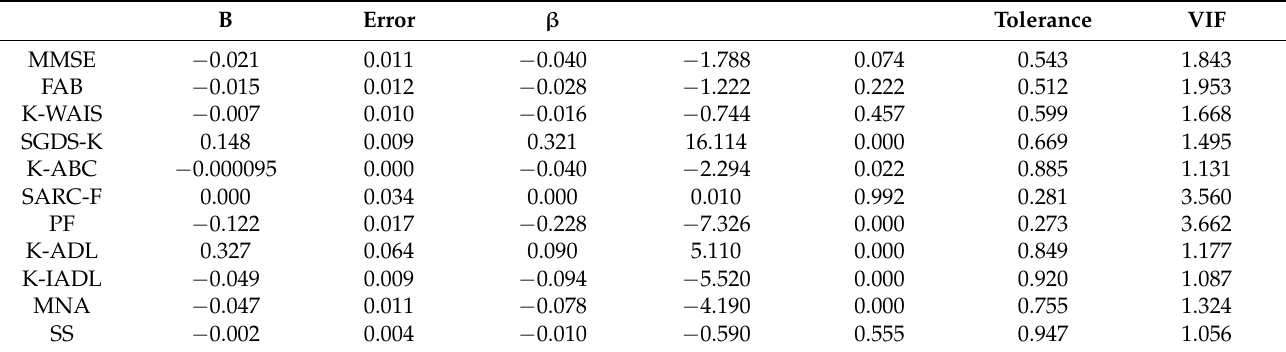
Table 3. Standardization coefficients (B)/non-standardization coefficients ( β ), significance probabili- ties, and collinearity statistics of independent and dependent